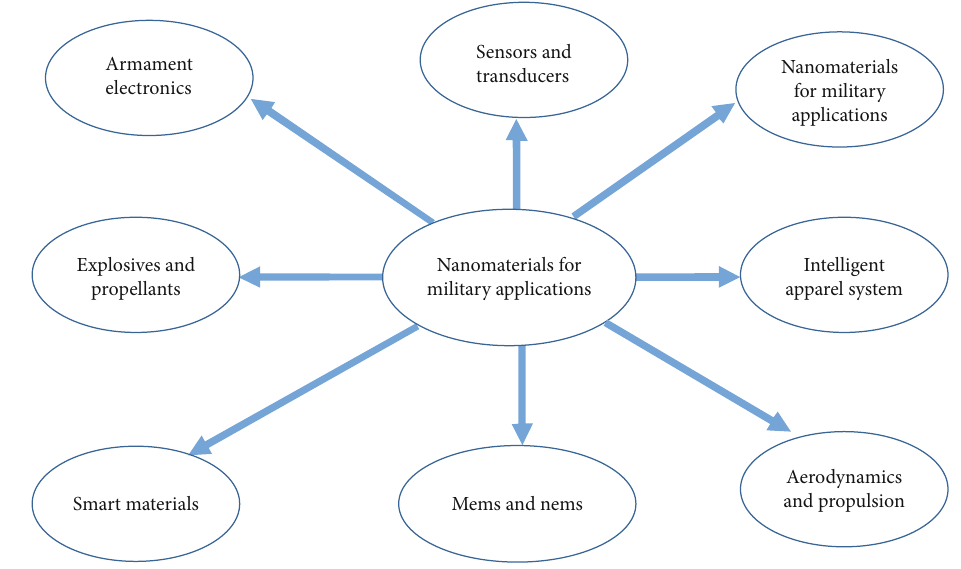
Figure 4: Various nanomaterials used in defense and military sectors [67].